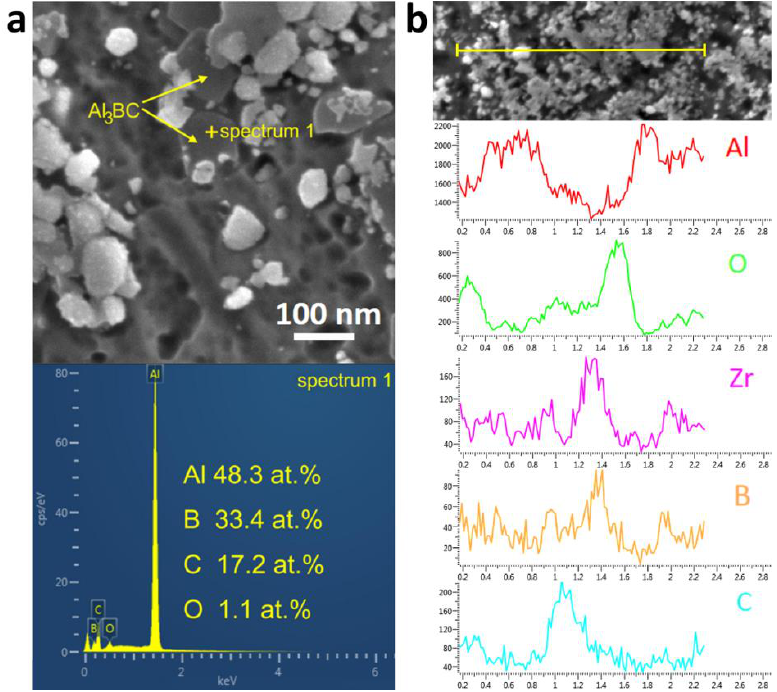
Figure 3. EDS result of the (ZrB 2 + Al 3 BC + Al 2 O 3 )/Al composite: ( a ) Point analysis of the Al 3 BC; ( b ) Line scanning images of a typical area.